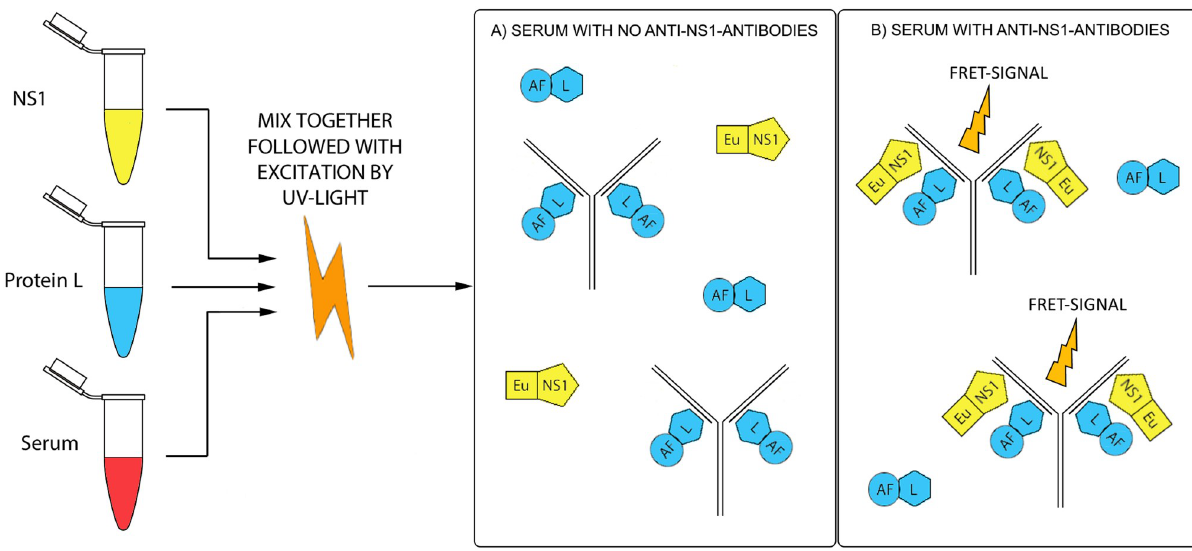
Fig 1. The LFRET assay principle. The Eu-labeled antigen (ZIKV NS1), Alexa-Fluor-labeled protein L and the serum sample are mixed together in a 384-well microplate. The former binds to the light chains of the antibodies, which if ZIKV-NS1-specific also bind the europium-labeled NS1 antigen. The mixture is exposed to UV light and the close proximity allows the donor and acceptor to elicit the FRET signal, which is measured.